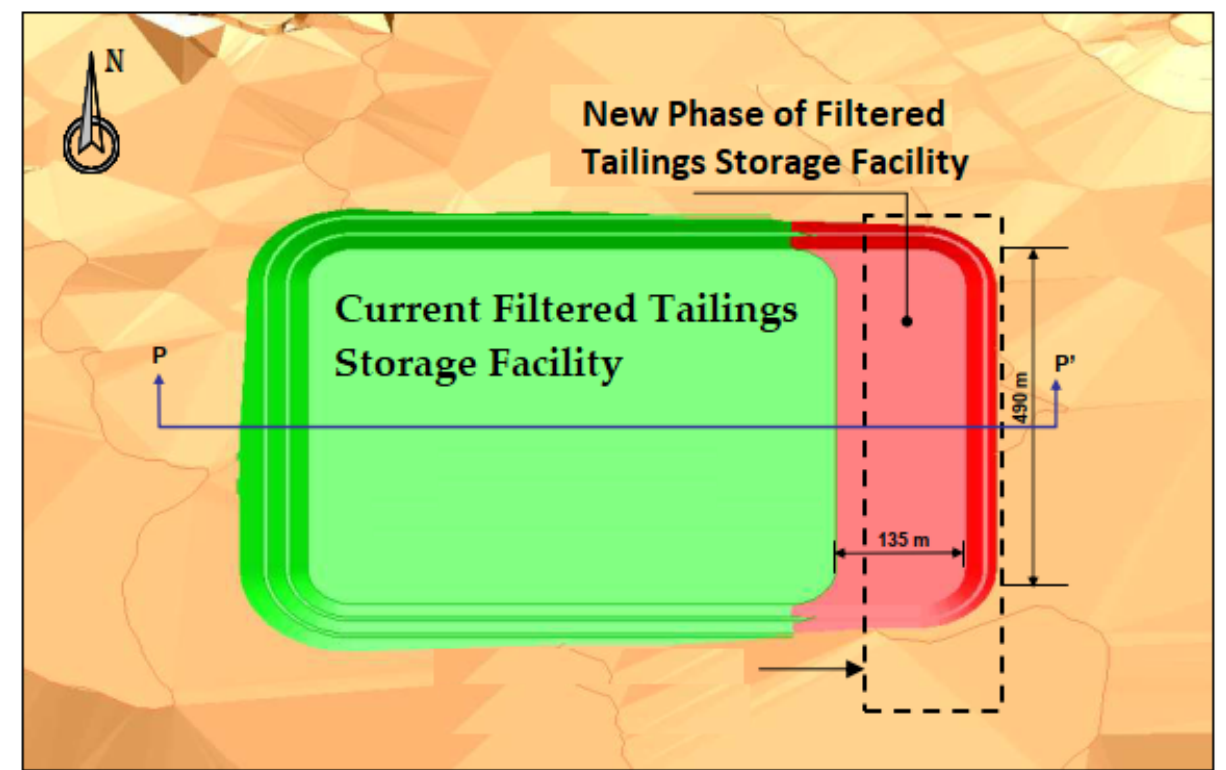
Figure 30. El Peñon Filtered Tailings Storage Facility—Old and New Phase Layout [62,63].